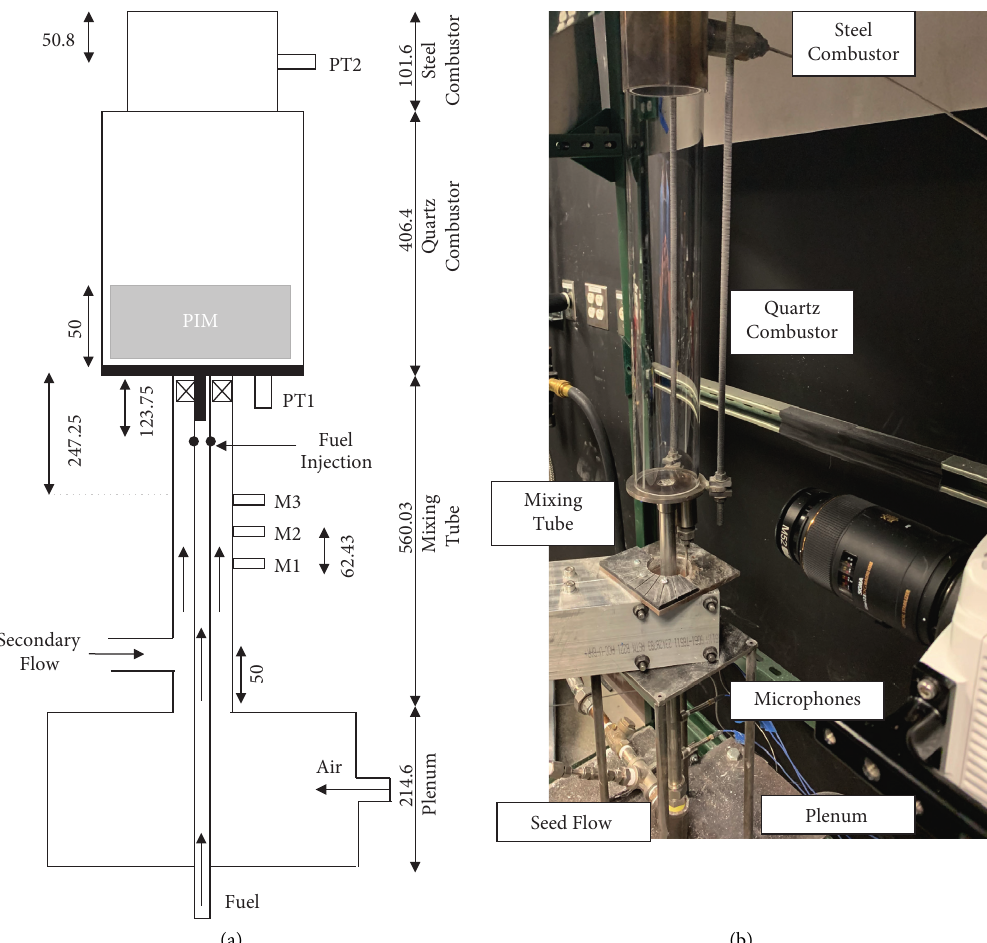
Figure 1: (a) Schematic detailing the (b) physical combustor setup. All units are in millimeters.